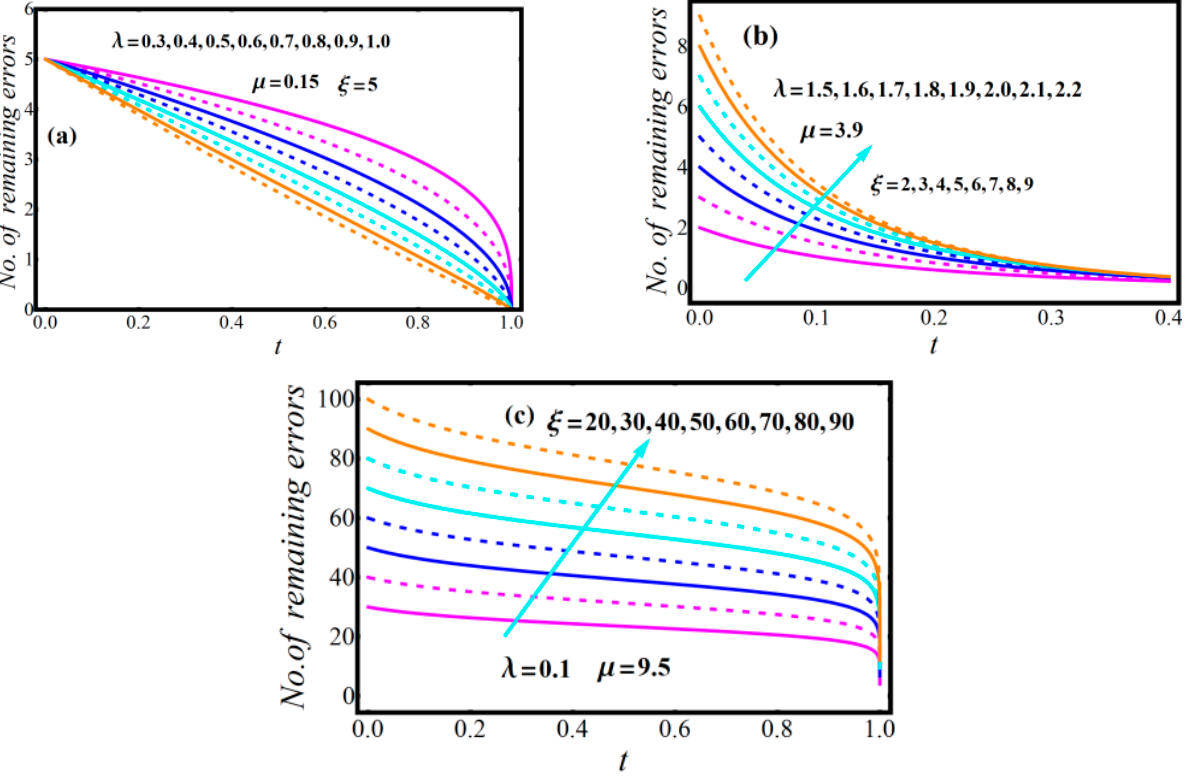
Figure 2. Visualization of the intensity function of the NHPP–NPF model.